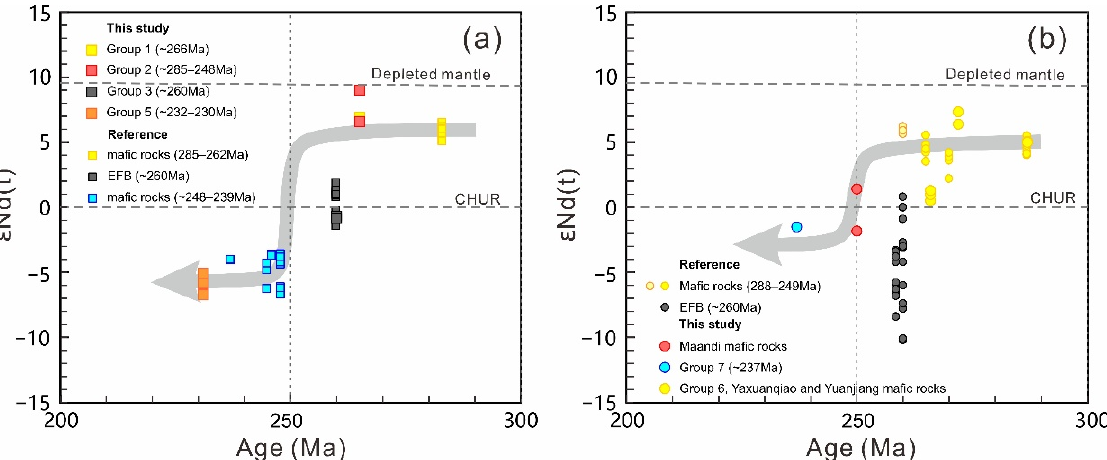
Figure 10. Age vs. ε Nd(t) diagrams of the Jinshajiang and Ailaoshan mafic rocks. ( a ) Mafic rocks in the Jinshajiang orogenic belt; ( b ) Mafic rocks in the Ailaoshan orogenic belt. Detailed data sources are listed in Supplementary Table S9.